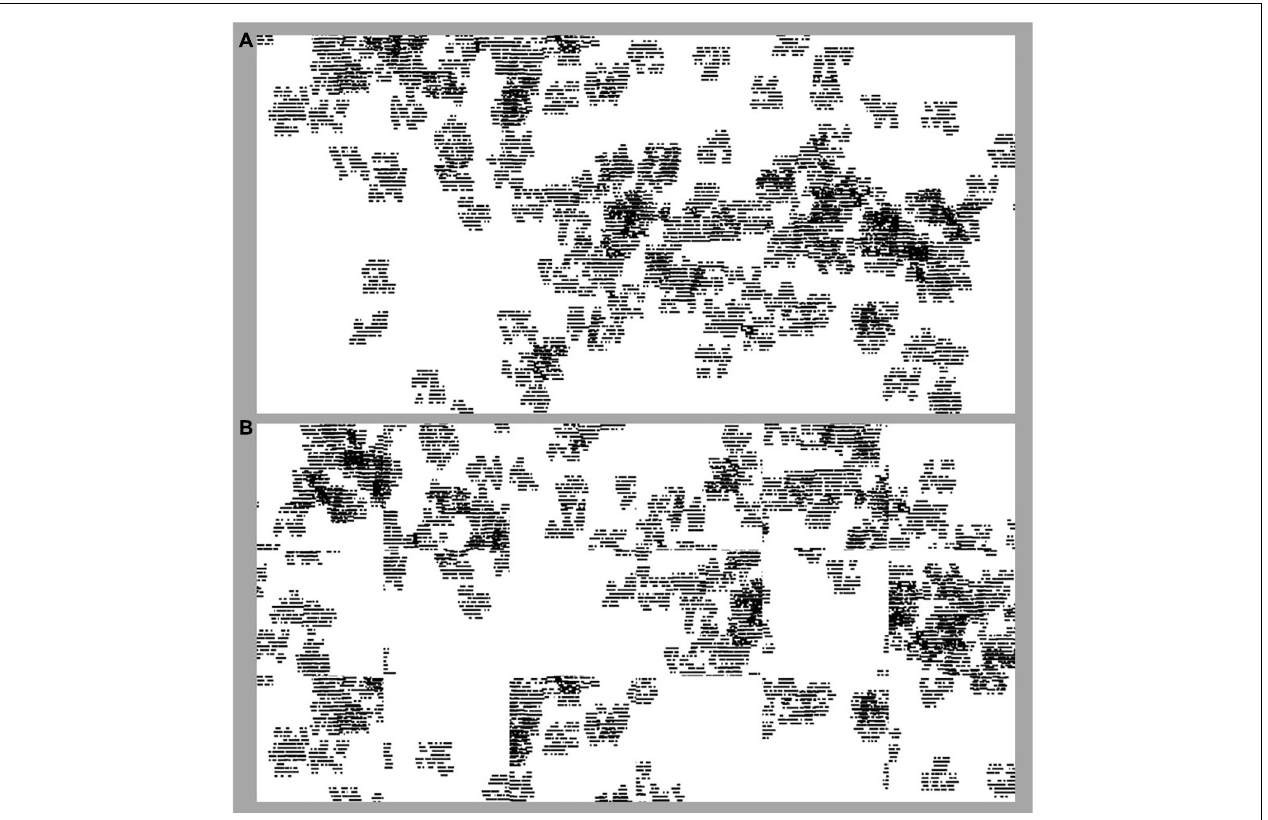
FIGURE 3 | Fractal ‘forests.’ The forests integrate the flights of Figure 1 with the seed design of Figure 2 . (A) is an image of the original (i.e., before randomization) forest pattern with D = 1.6; (B) shows the same forest after it has been divided into tiles and the tiles